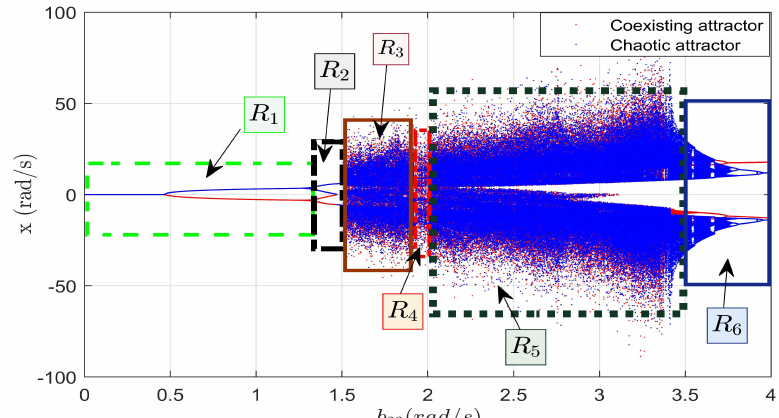
Figure 6. Bifurcation diagram in the second basin for the coexisting attractor in system (2).